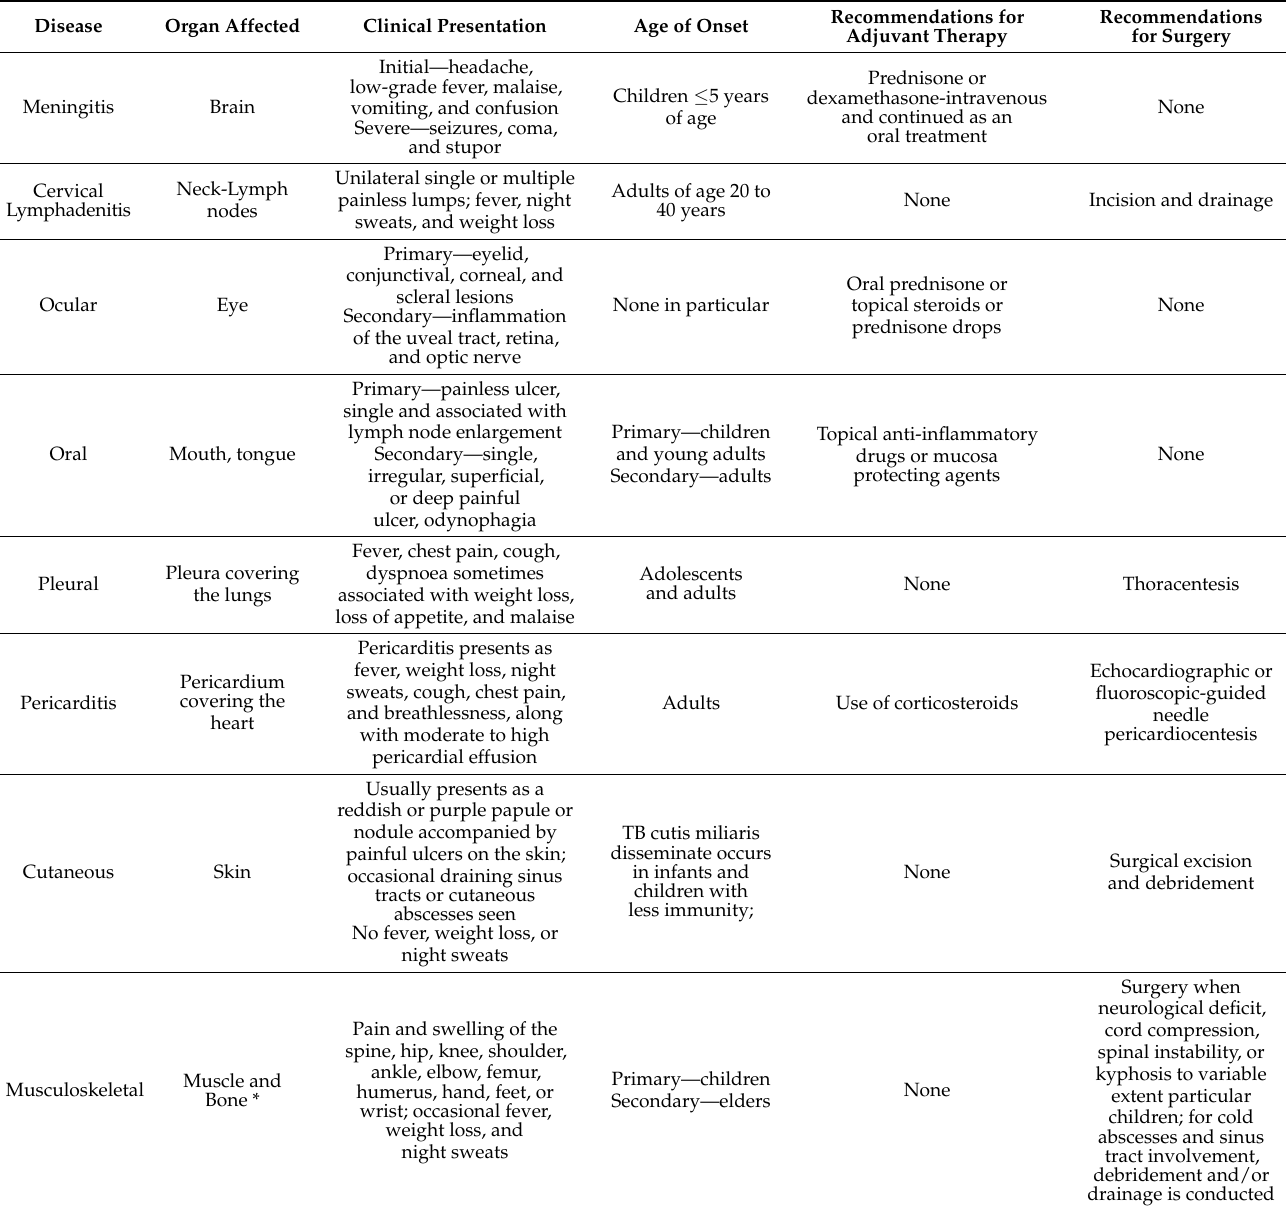
Table 1. Summary of EPTB disease, organs affected, clinical presentation, age of onset, and recommendations for adjuvant therapy or